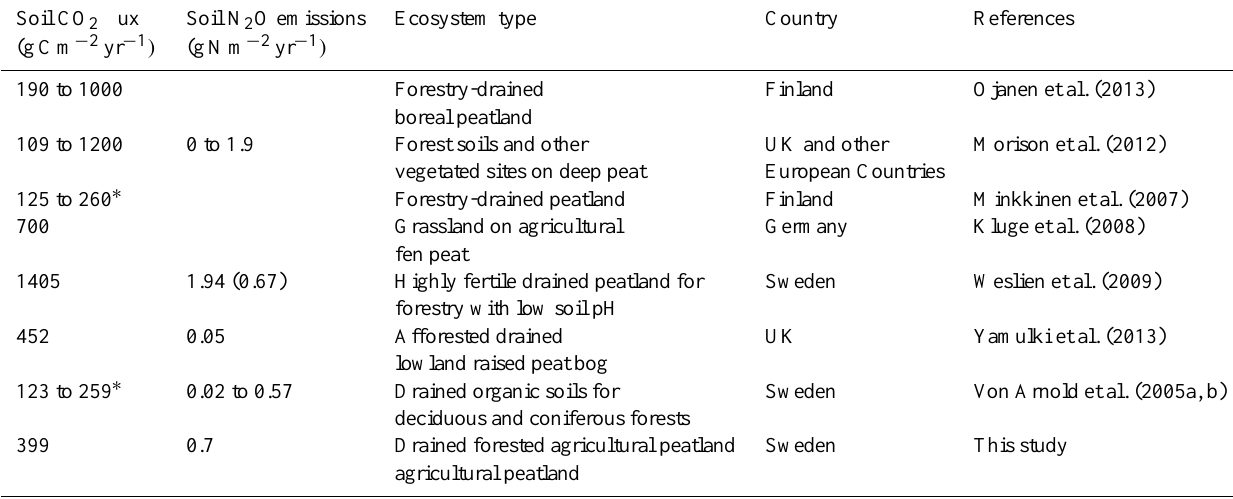
Table 3. A comparison of soil peat CO 2 and N 2 O emissions in the present study with values published in the literature. Soil CO 2